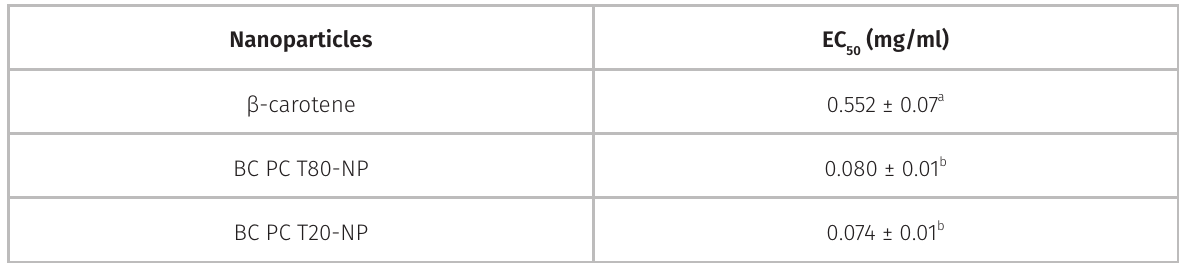
Table IV. Antioxidant activity of β-carotene and nanoparticles determined by the DPPH method.